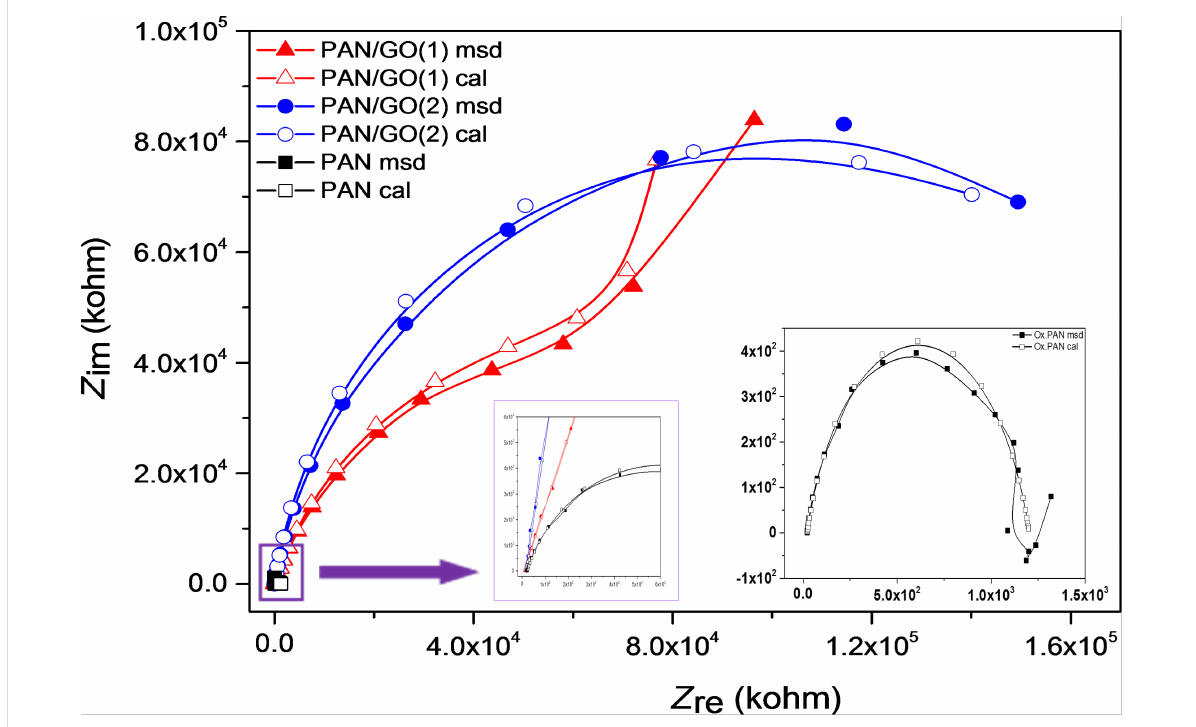
Figure 12: Nyquist plots of oxidized PAN and GO-containing oxidized PAN nanofiber webs (inset: Nyquist plots of oxidized nanofiber webs at high frequencies and Ox.PAN nanofiber webs up to 100 kHz).